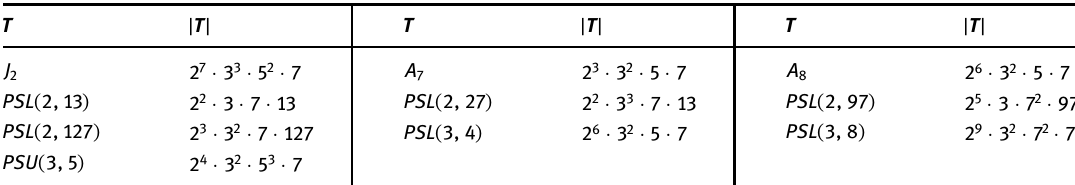
Table 2: The simple K 4 - groups in Lemma